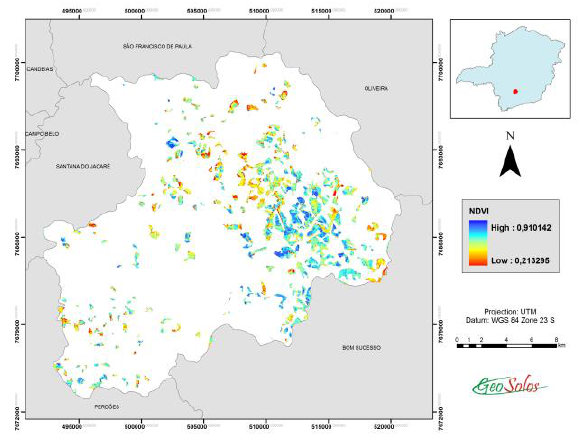
Figure 2. NDVI of coffee fields of Santo Antonio do Amparo, Minas Gerais, Brazil.